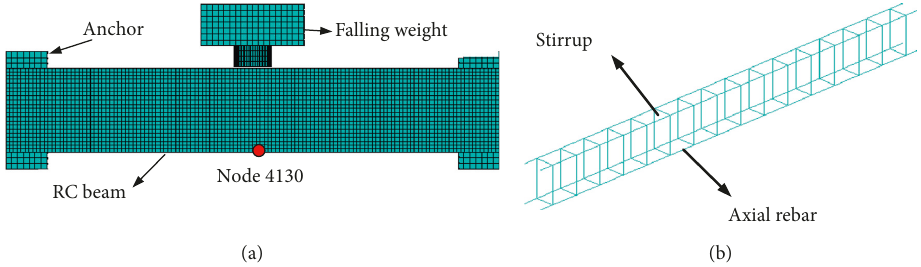
Figure 4: Impact response comparisons of RC beam at the speed 4.6m/s. (a) Time-history curve of midspan displacement. (b) Time-history curve of impact force.